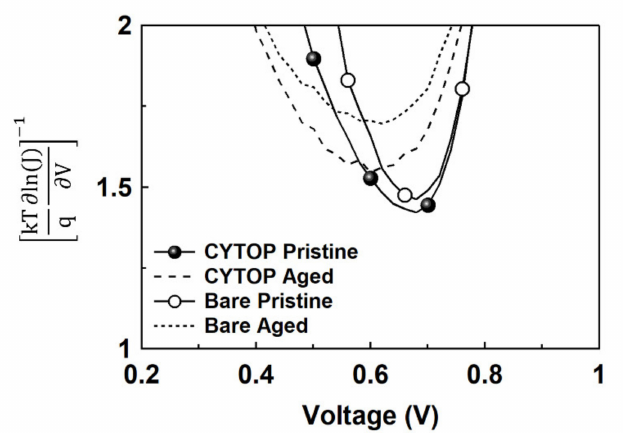
Figure 5. Ideality factor of CYTOP-encapsulated and bare OSCs extrapolated from the current density–voltage (J–V) characteristics in dark conditions.